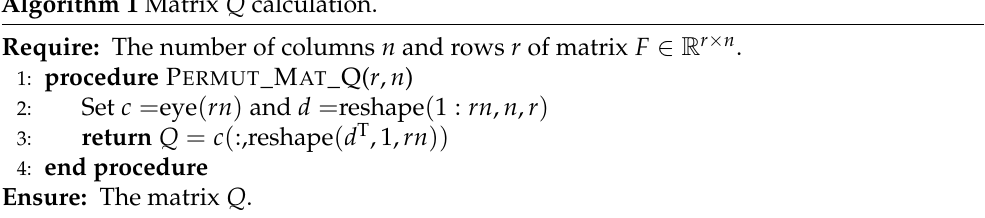
Algorithm 1 Matrix Q